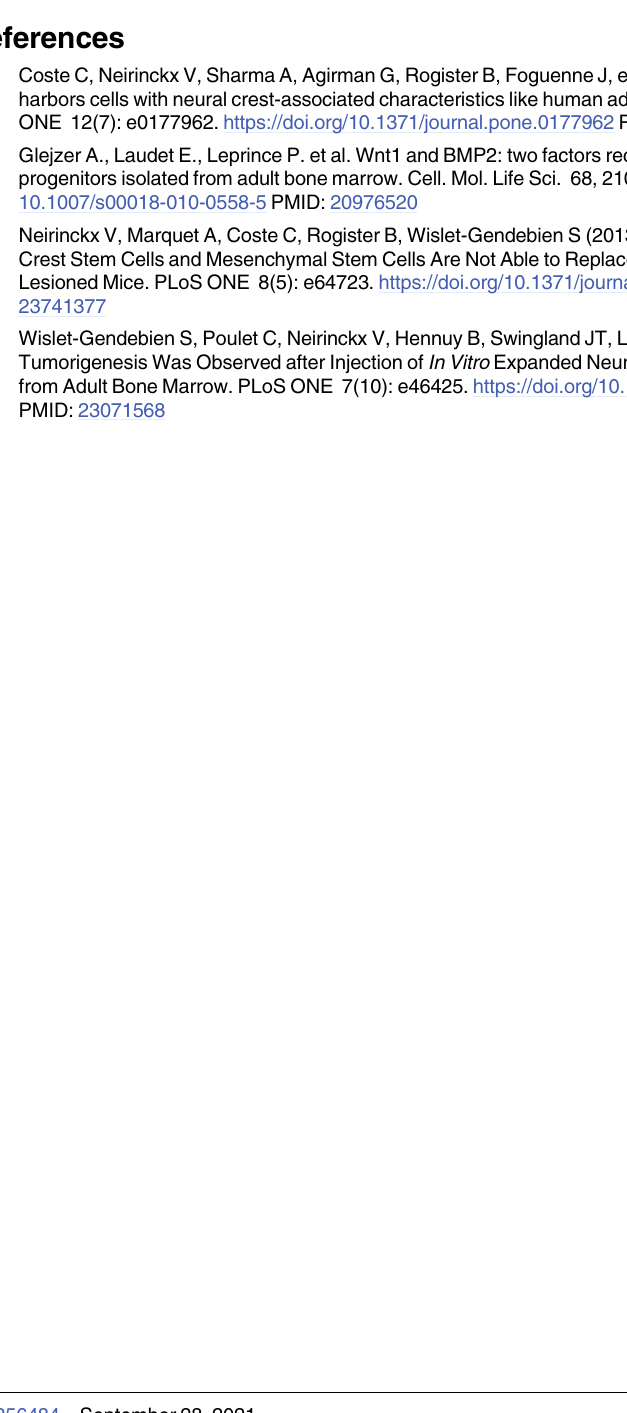
S5 File. Raw data underlying S2